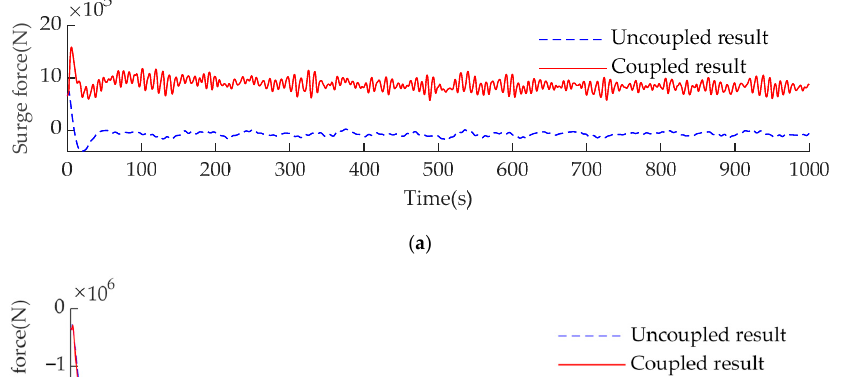
Figure 13. Time histories for the vessel’s six degrees of freedom of motion for uncoupled and coupled results: ( a ) Surge, ( b ) Sway, ( c ) Heave, ( d ) Roll, ( e ) Pitch, and ( f ) Yaw.